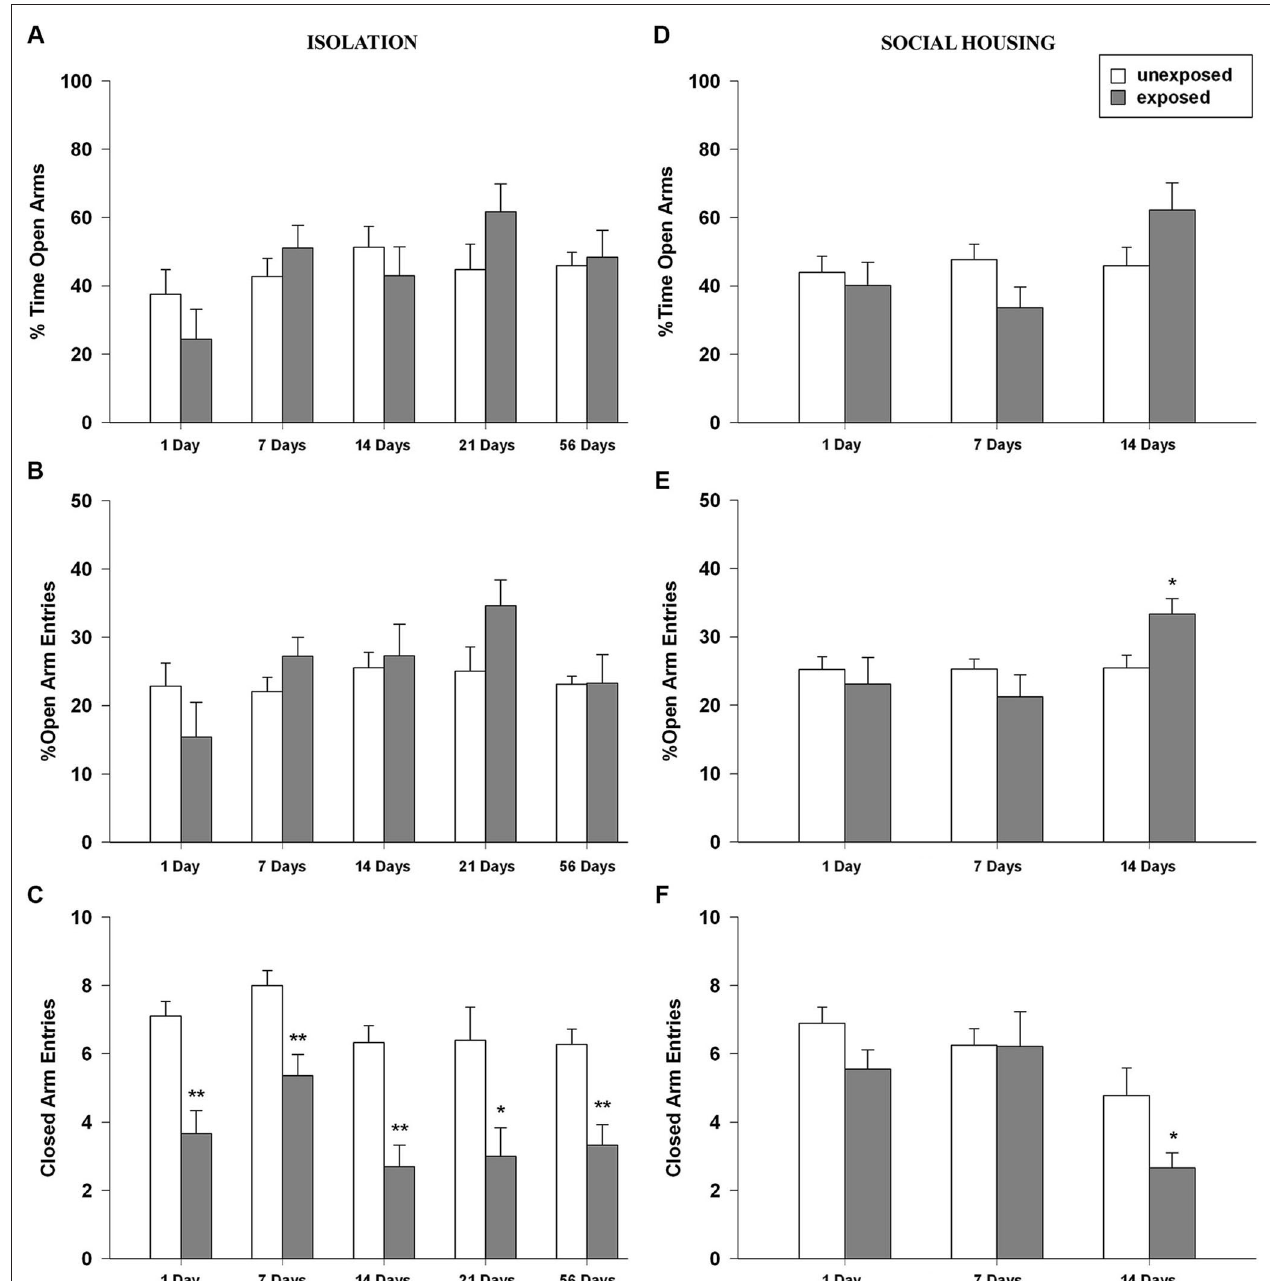
FIGURE 4 | (A,D) Percentage of time in the open arms, (B,E) percentage of open arm entries and (C,F) closed arms entries of rats unexposed or exposed to the footshock in the EPM 1, 7, 14, 21 days after exposure to the stressor ( n = 8–11). Data are expressed as mean + SEM (* p < 0.05; ** p < 0.01).